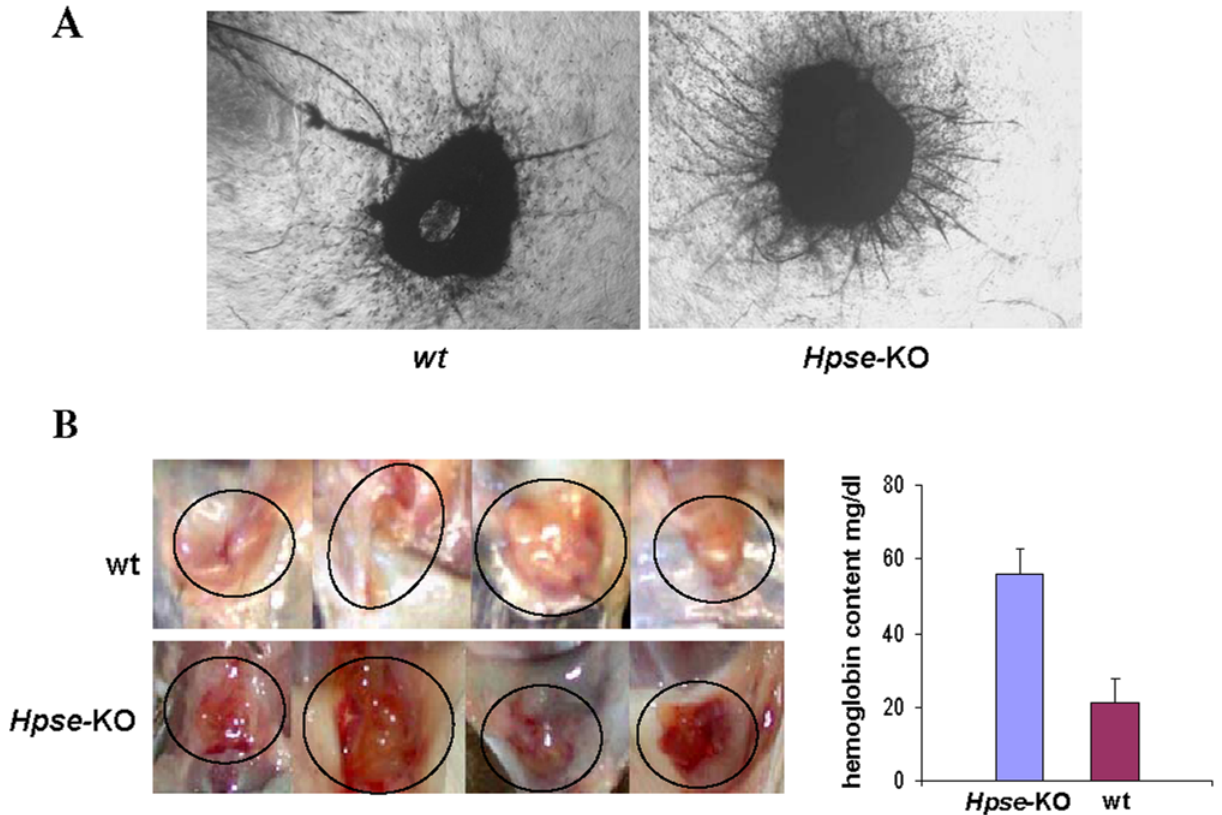
Figure 4. Endothelial sprouting and angiogenesis. A. FGF-2 induced vascular sprouting in the aortic ring model. Hpse- KO and wt derived aortic rings were subjected to FGF-2 induced vascular sprouting for 6 days. The rings were then fixed, stained with 0.02% crystal violet and evaluated for vascular sprouting. A more extensive endothelial sprouting was noted in Hpse- KO derived rings (right panel) as compared to wt derived rings (left panel). B. Matrigel plug assay. Hpse- KO (lower panels) and wt (upper panels) mice were injected subcutaneously with 200 m l of growth factor depleted Matrigel supplemented with FGF-2 (80 ng/ml). Seven days later, the Matrigel plugs were excised and photographed, followed by homogenization and determination of hemoglobin content using Drabkin’s reagent (right). A pronounced angiogenic response was noted in Hpse- KO vs. wt mice (55 6 7.18 mg/dl vs. 21 6 6.2 mg/dl; p # 0.0002, respectively).